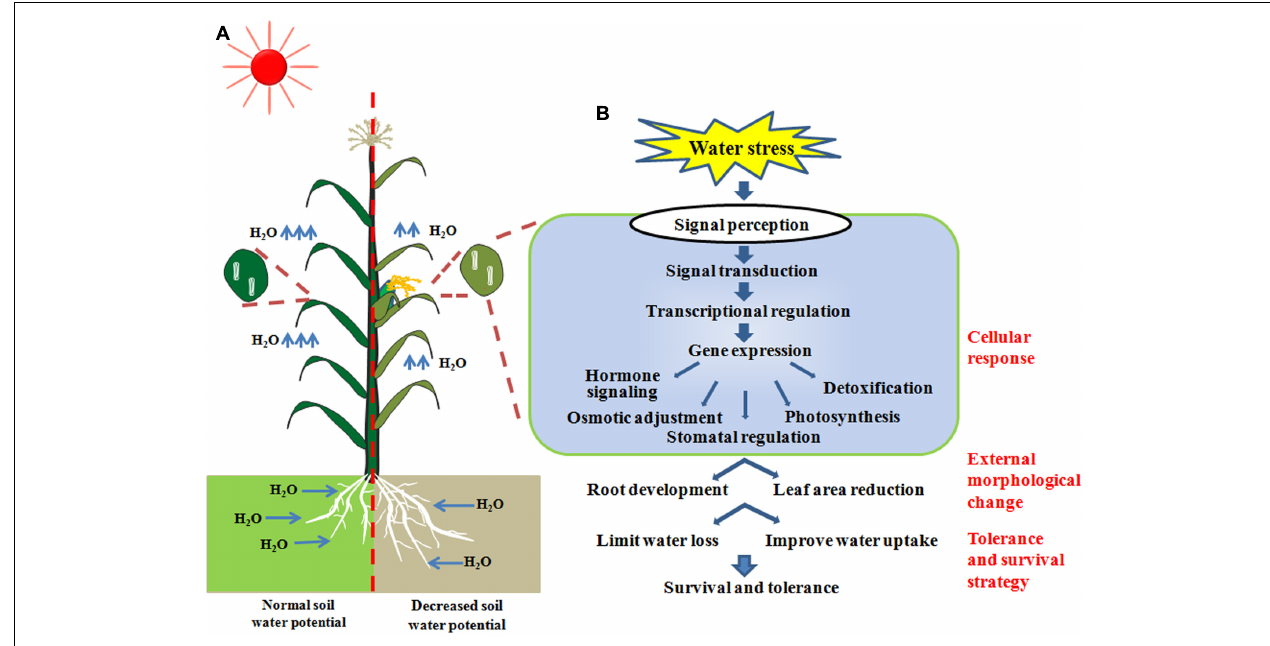
FIGURE 1 | (A) The physiological and morphological adaptations of plants grown under water-deficit conditions. (B) Cellular response to water stress, including signaling transduction and physiological changes to achieve survival